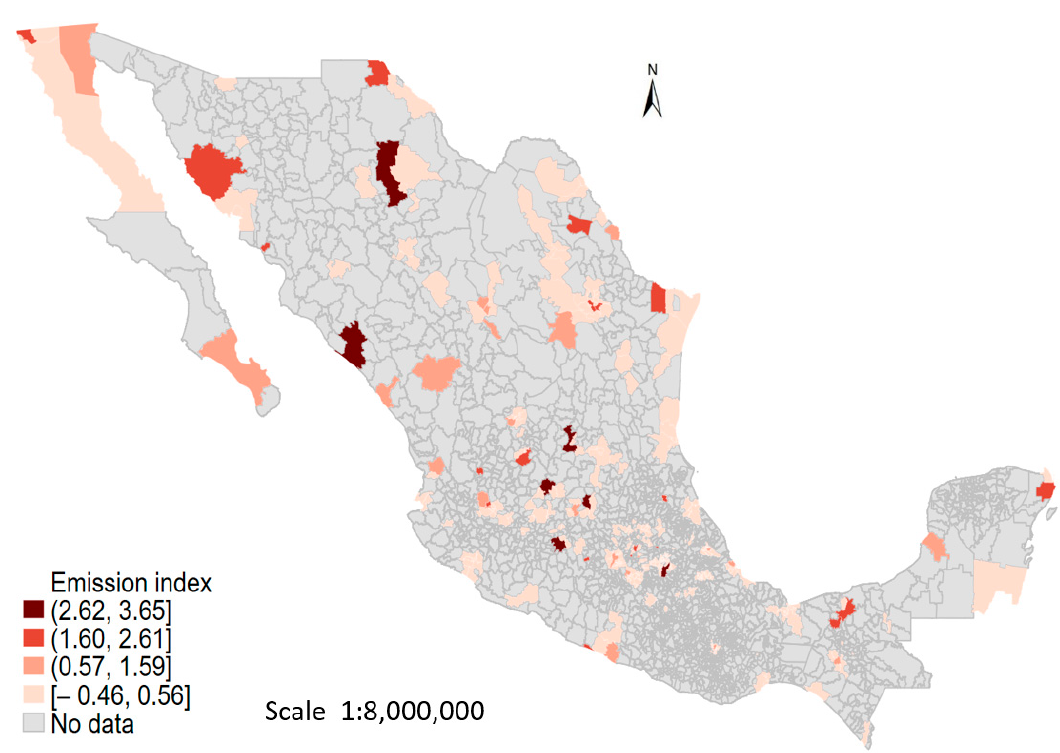
Figure 4. Emissions index for 405 metropolitan municipalities in Mexico in 2016.